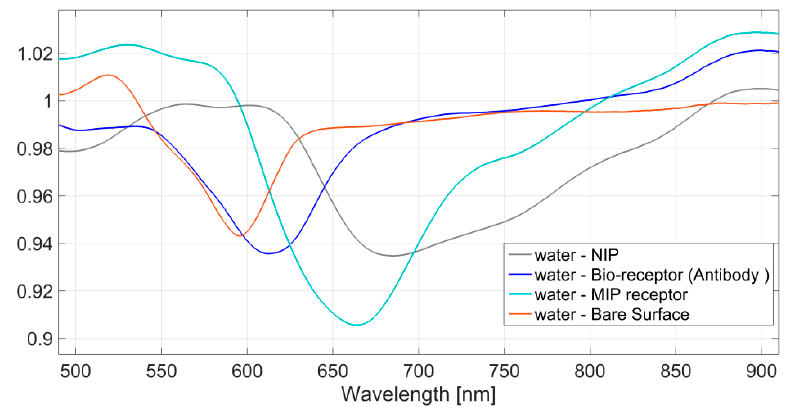
Figure 6. SPR spectra acquired in the presence of water on different surfaces: bare, with a bio-receptor, with an MIP receptor and with an NIP layer.